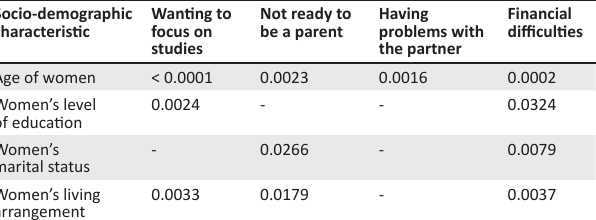
FIGURE 1: Percentage of contraceptive use by the respondents.